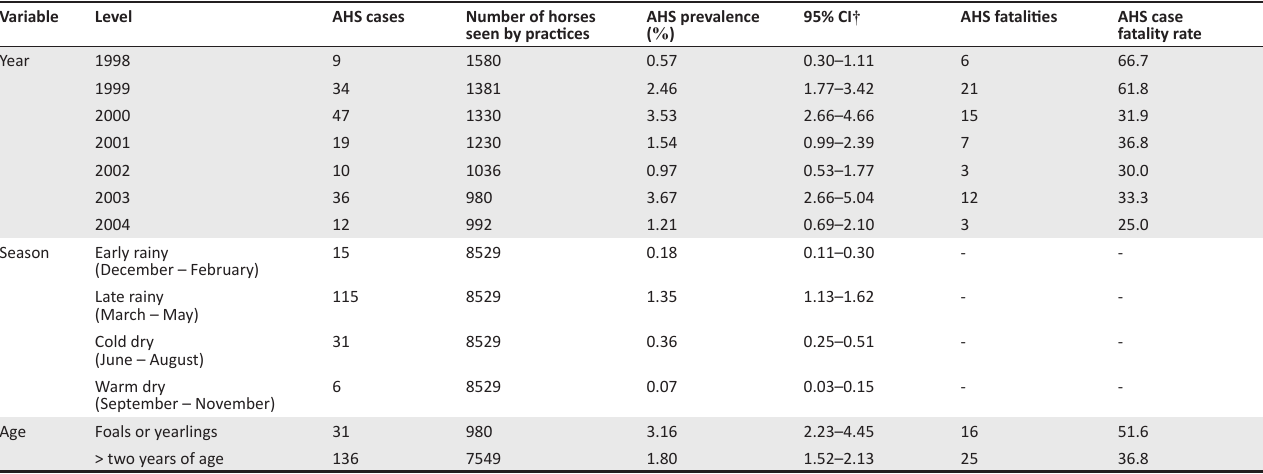
TABLE 1: The annual practice prevalence of African horse sickness in horses recorded by two Harare equine practices for the period 1998–2004. Variable Level AHS cases